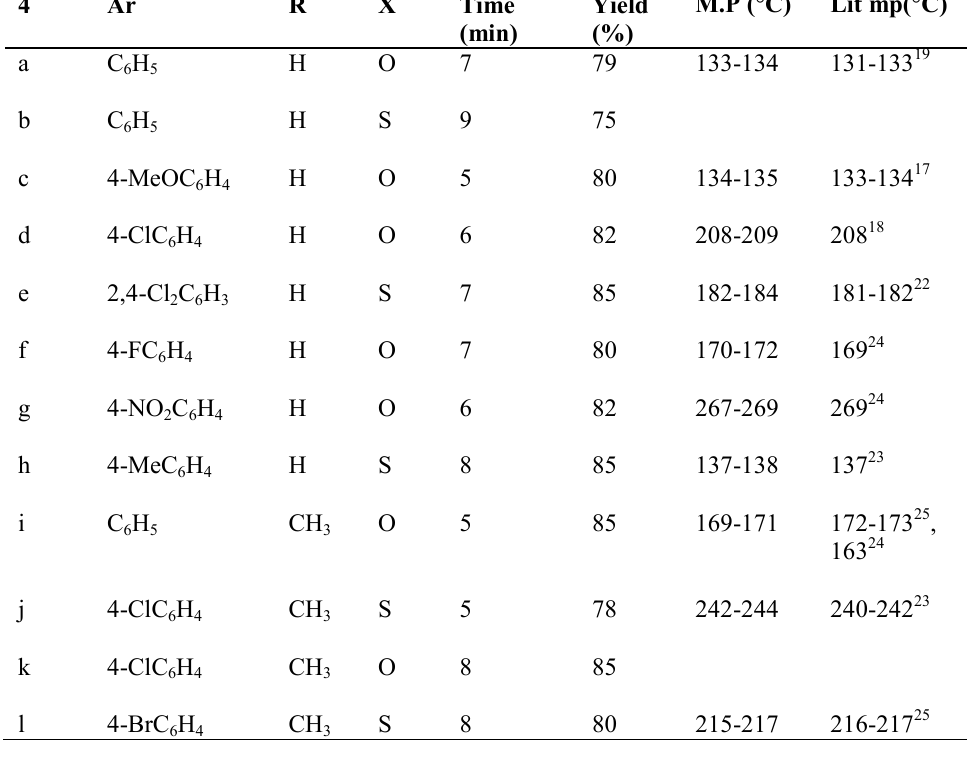
Table 1. Synthesis of products 4 under microwave